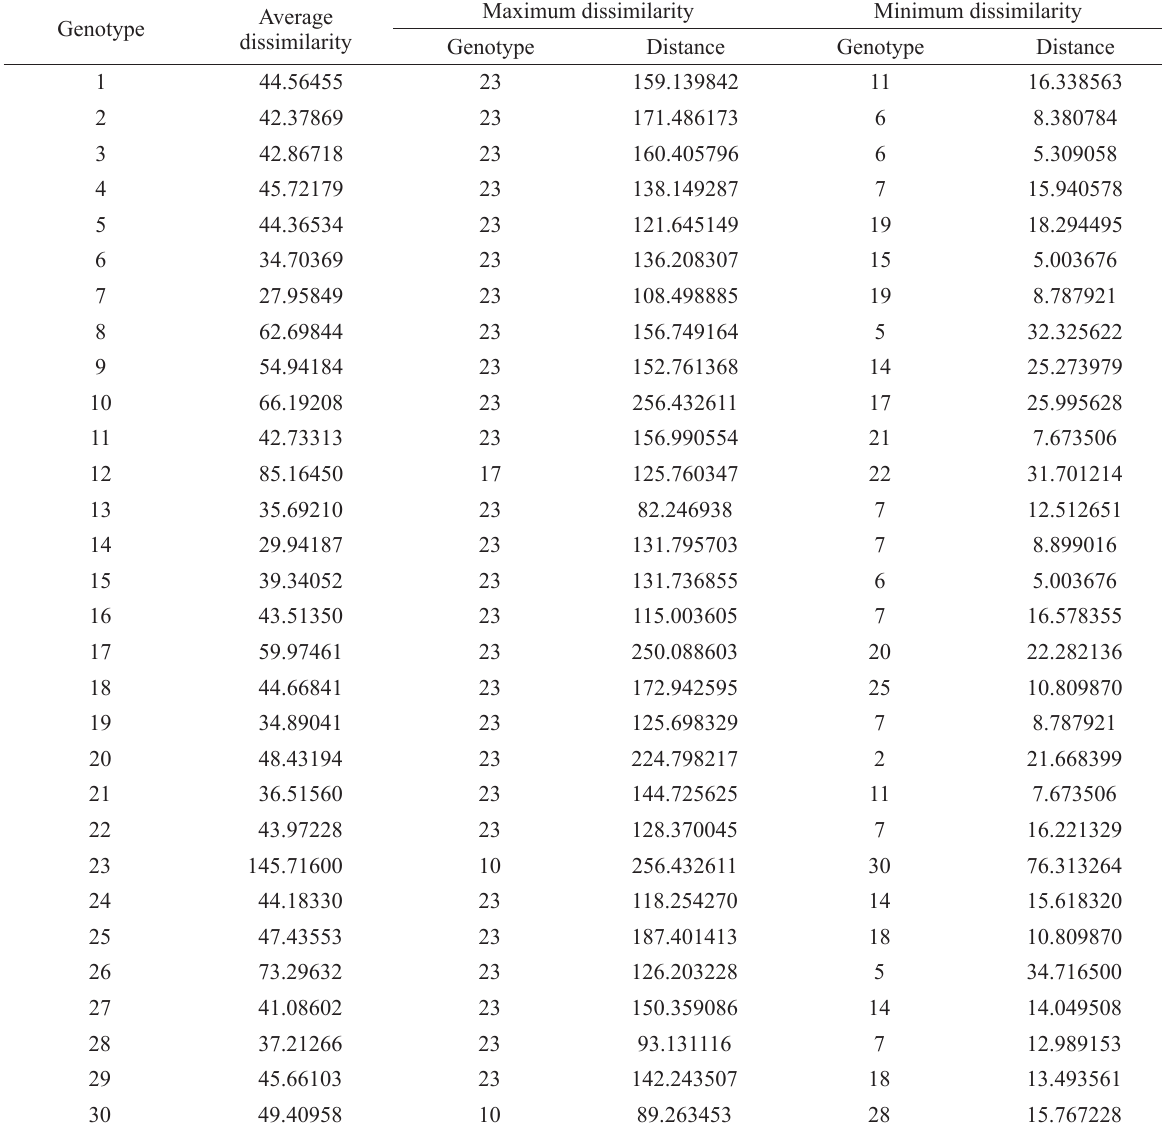
Average, maximum, and minimum dissimilarity for 30 promising registered Coffea canephora genotypes based on generalized Mahalanobis distance (D 2 ), considering 15 morpho-agronomic traits 1 . Vila Valério - ES,